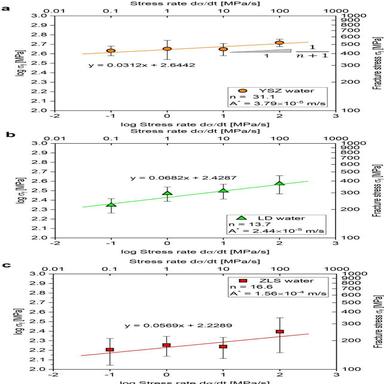
Dynamic test results relating the fracture stress to the stress rate for YSZ(a), LD(b), and ZLS(c) (All tests were performed in water).